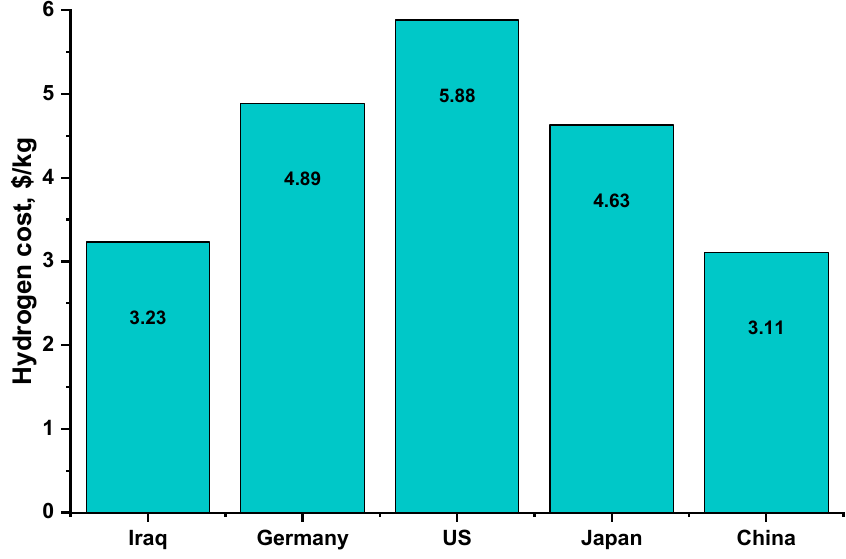
Figure 11. Hydrogen cost compared with other countries.